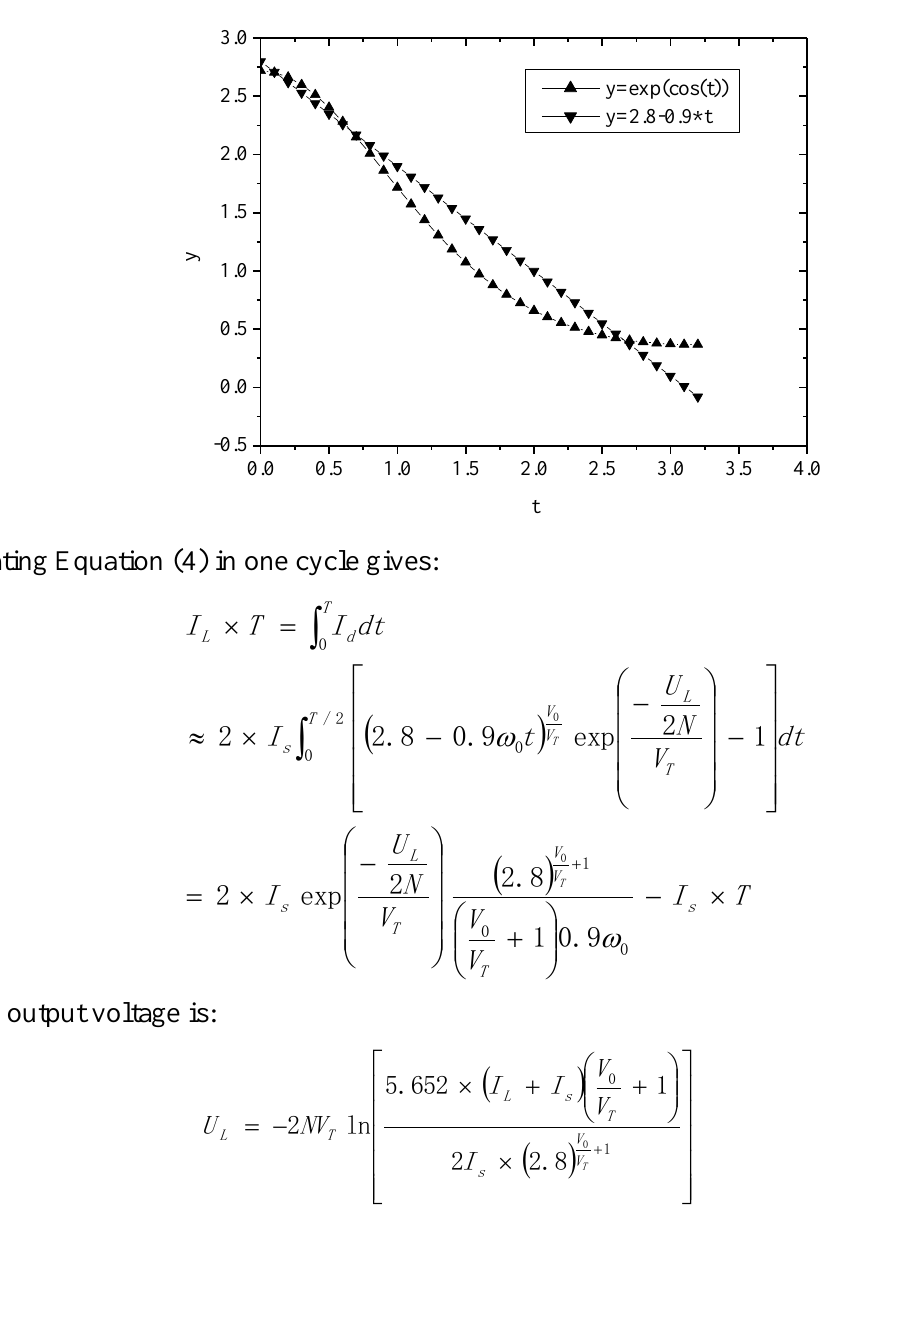
Figure 2. Linear approximation of exponential trigonometric